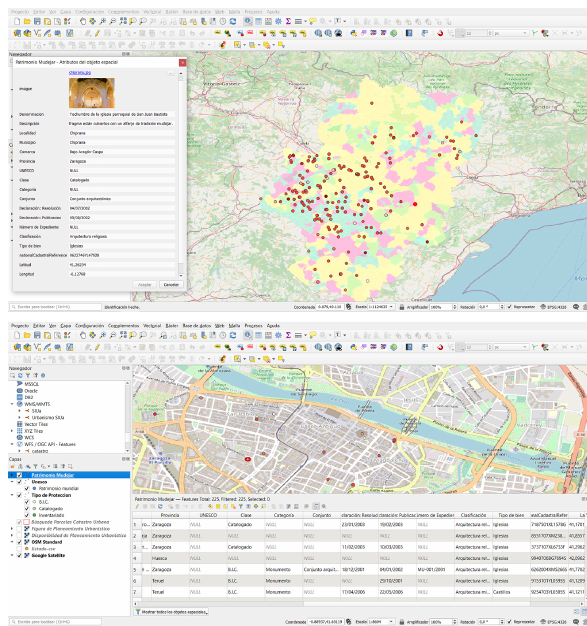
Figure 6. Creation of the Aragonese Mud´ejar Geo-DB in QGIS.